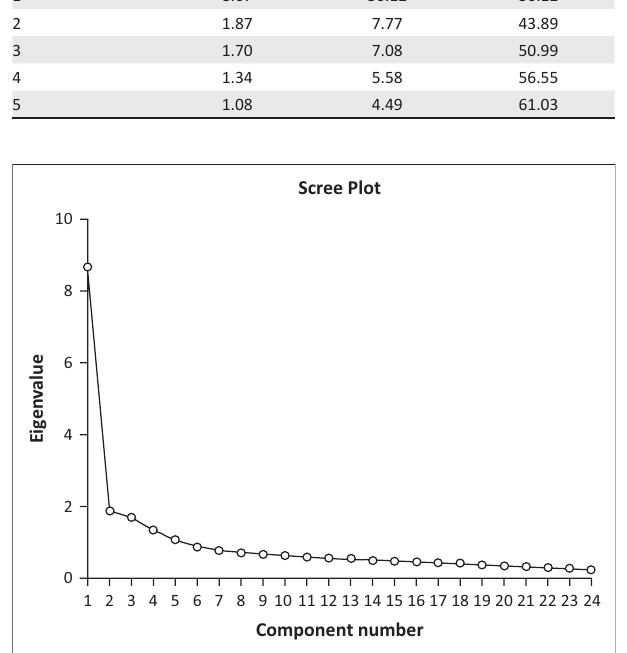
FIGURE 2: Cattell’s scree plot.